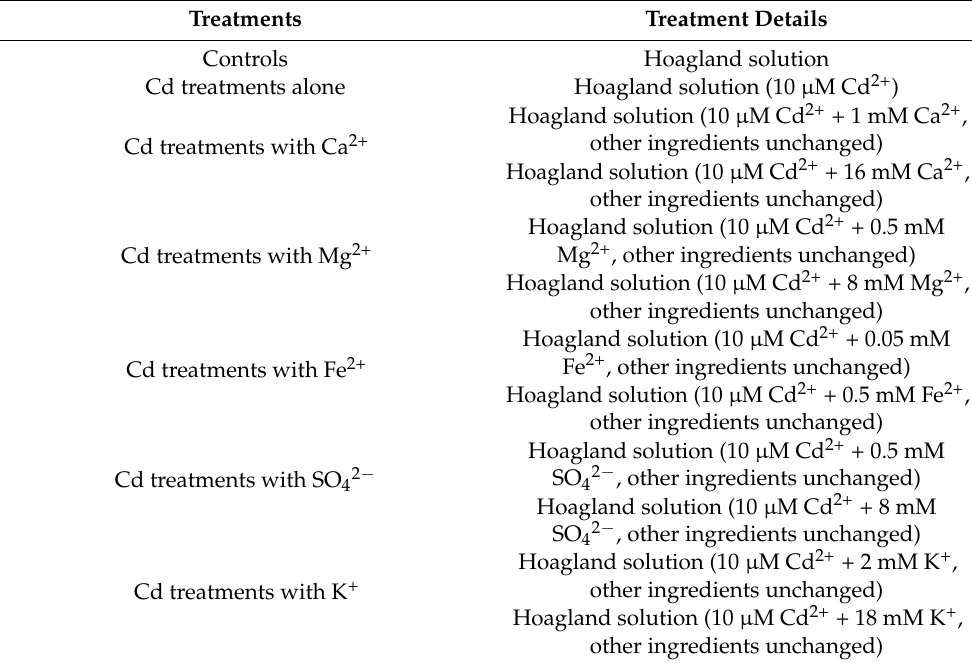
Table 1. Treatment design of additives to Hoagland solution in pots with Bidens pilosa